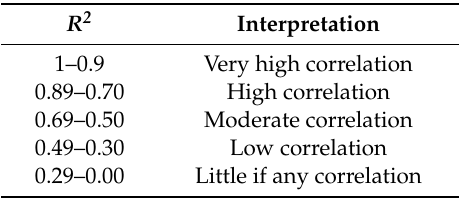
Table 9. The correlation coe ffi cient ranges and interpretation.